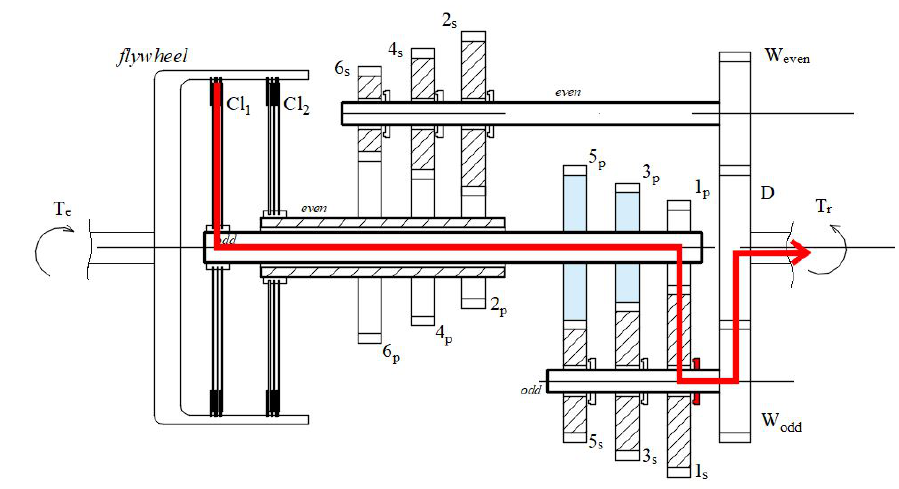
Figure 4. The DCT gear shifting transient: 1st gear